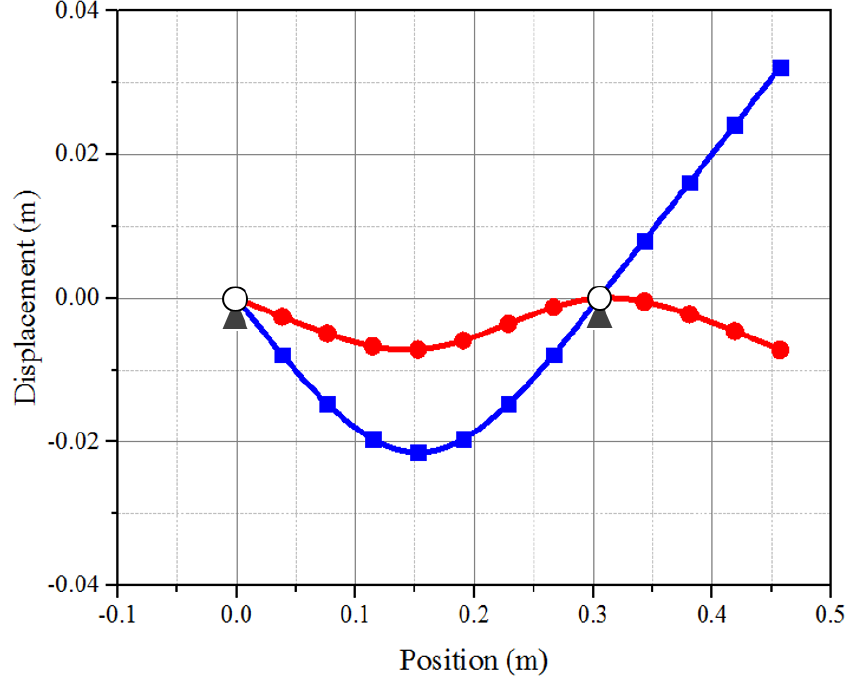
Figure 6. Transverse displacement of the free end node. ( CB method (free-free modes) and ANSYS (simply-supported CB method (free-free modes) and